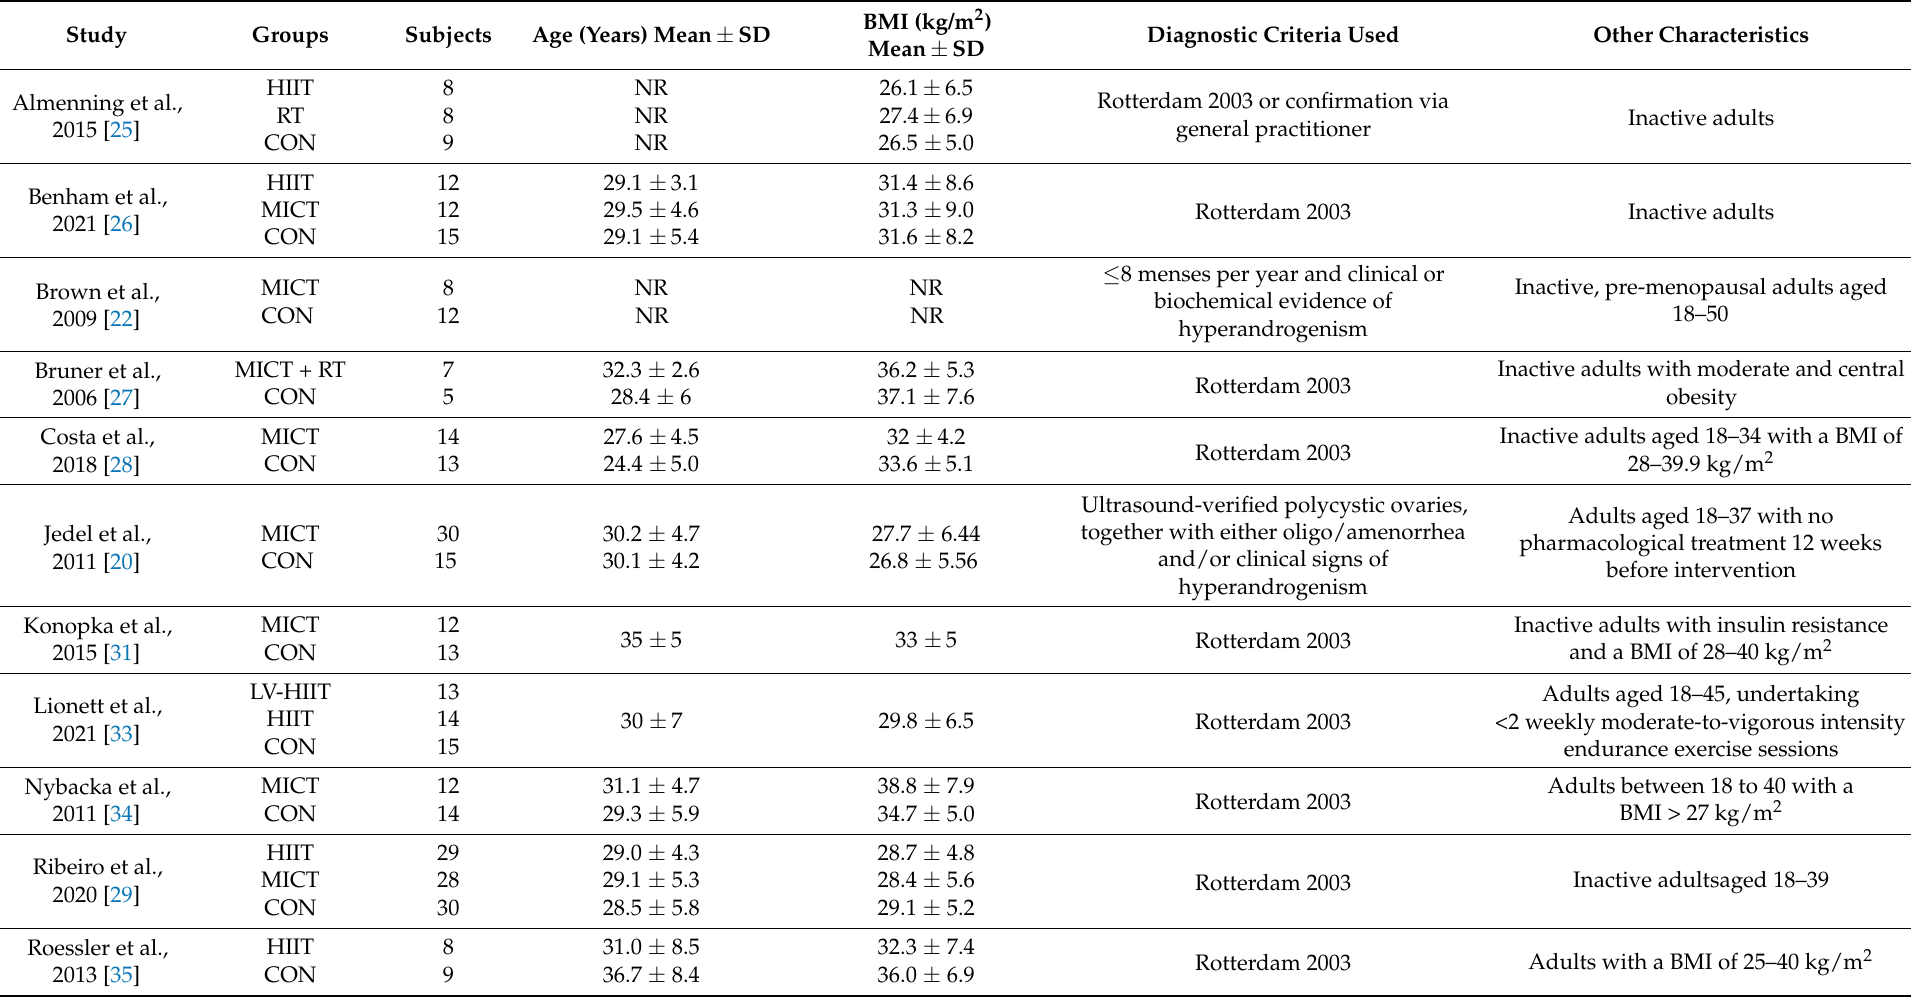
Table 1. Participant